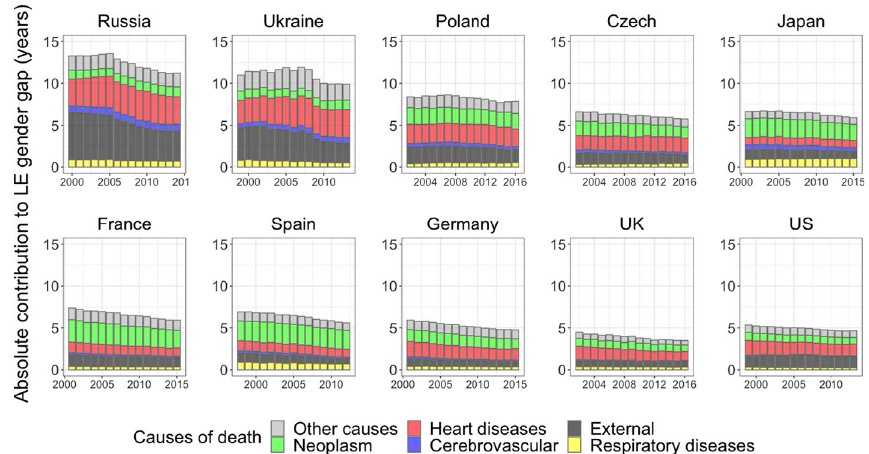
Fig. 5 Absolute cause-specific contributions to the sex gap in life expectancy over